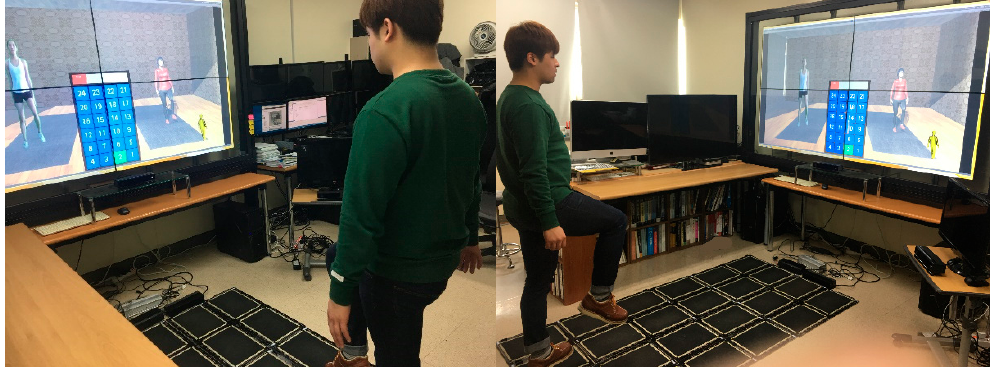
Figure 1. A user playing the Chongchong Step Master physical exercise game.